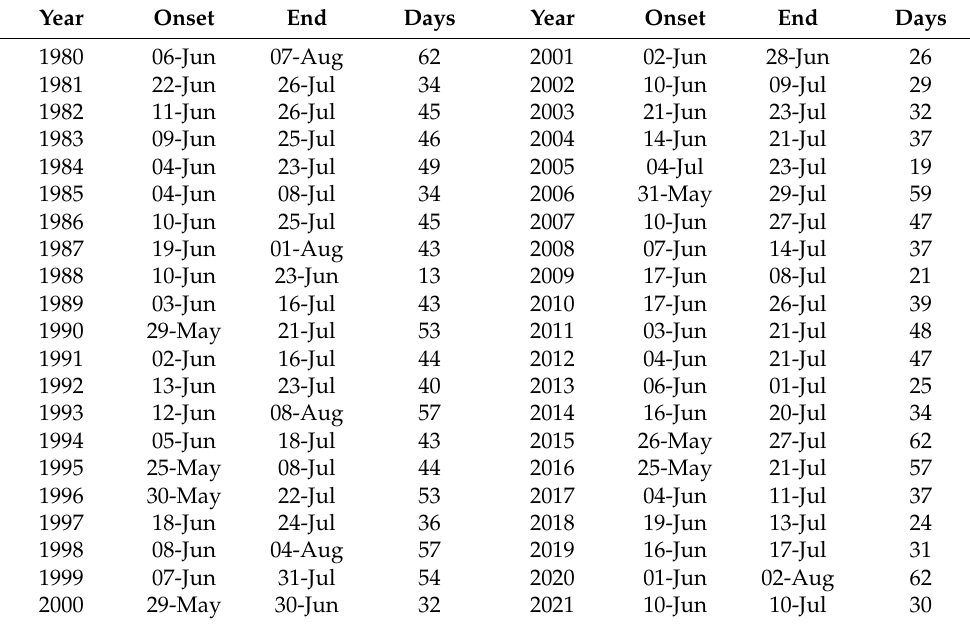
Table 1. The duration of the Meiyu season from 1980 to 2021, as determined by the National Climate Center of the China Meteorological Administration, in accordance with the Meiyu monitoring indices (GB/T 33671-2017) over the middle- and lower-reaches of the Yangtze